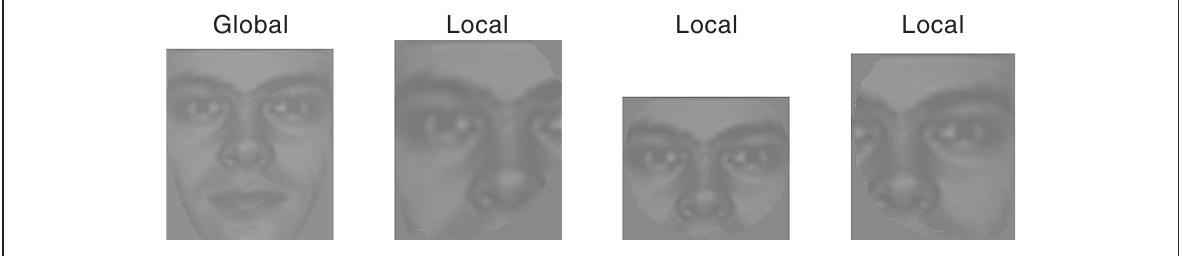
Figure 4. Face recognition contrast sensitivity functions of subjects S1 and S2. Circles and triangles rep- resent radial and angular filtering, respectively. Each point represents the mean of 5 measurements. Er- ror bars represent ± standard error of the